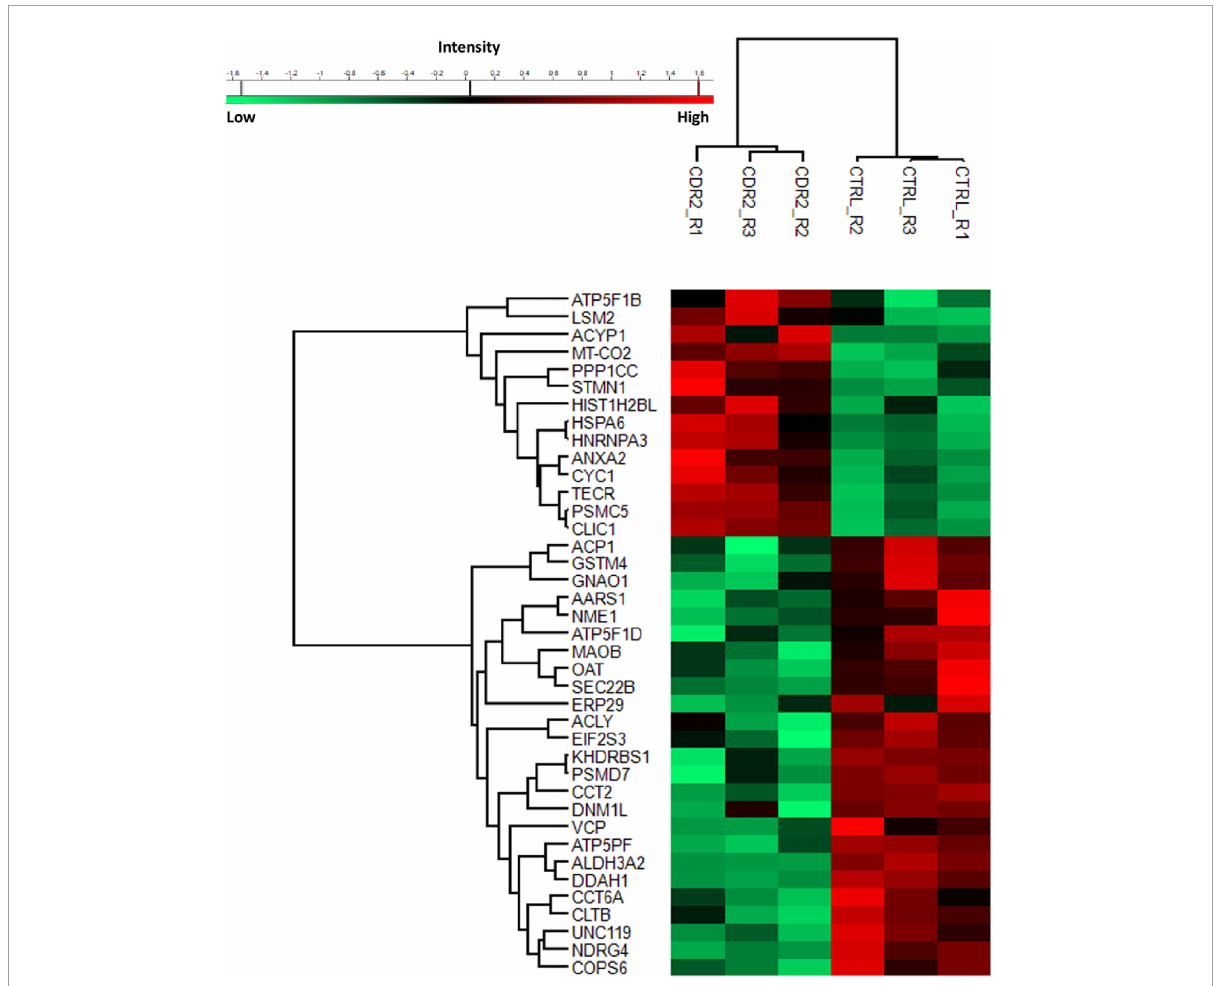
FIGURE4 Differential expression levels of significantly changed protein markers ( p < 0.05) in complementary-determining region 2 (CDR2)-treated retinal explants compared to untreated controls (CTRL). The highly expressed proteins are shown in red color and the low abundant proteins are labeled in green color between both experimental groups (CDR2 and CTRL group).